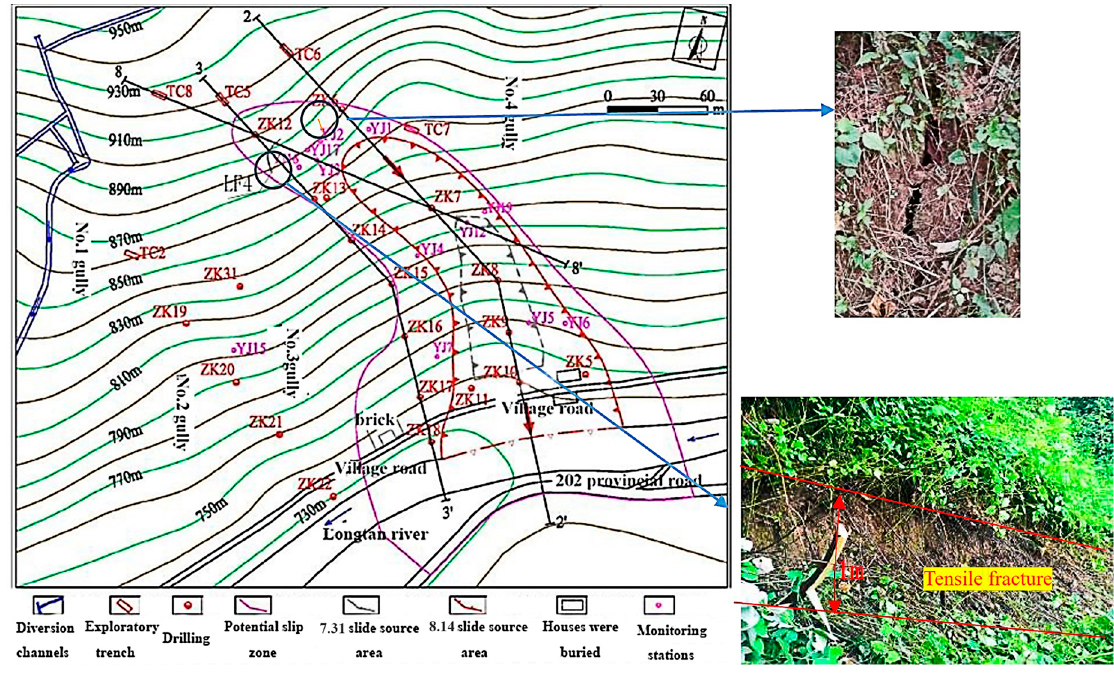
Figure 4. Topography plan and local features of the landslide